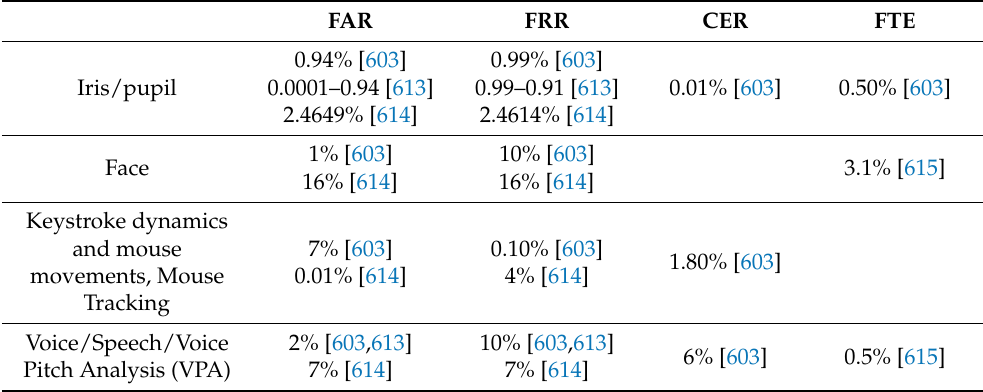
Table 12. Comparison of performance metrics for biometric technologies by various